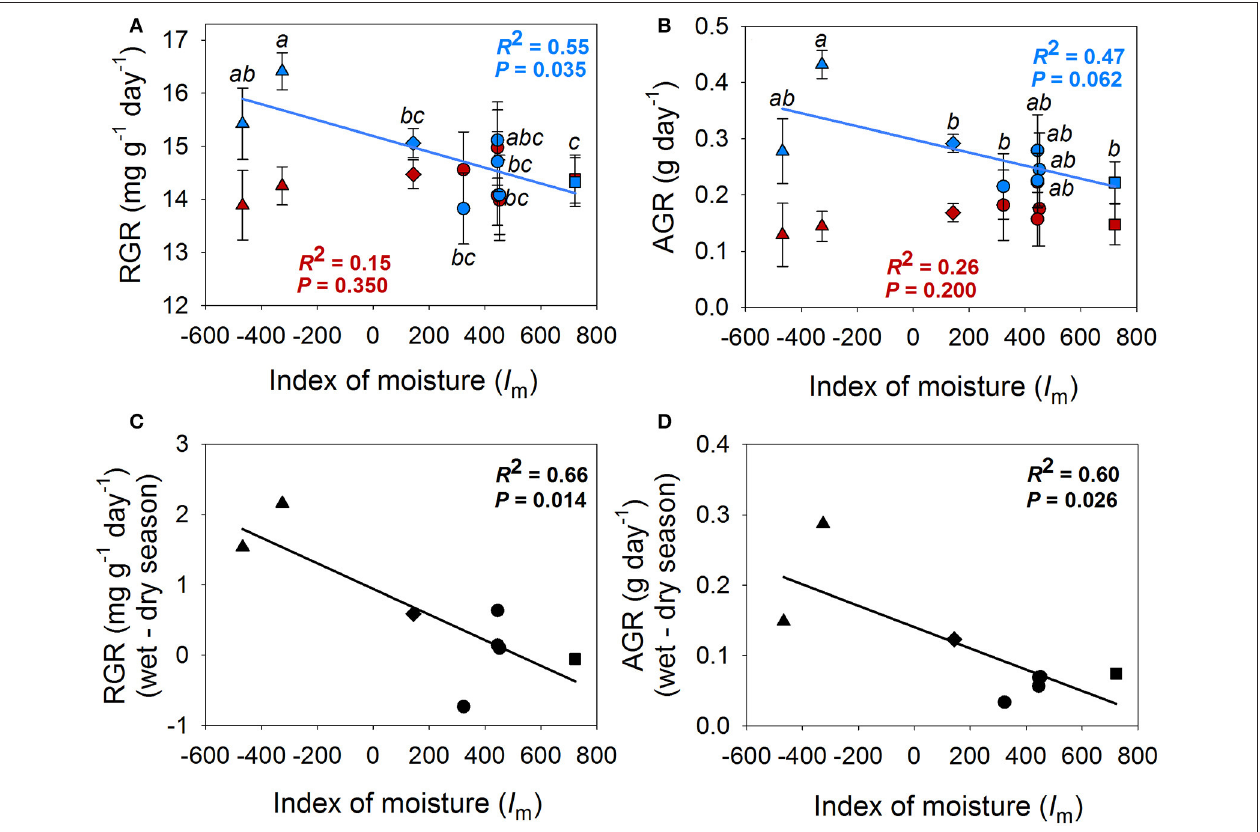
FIGURE 3 | Population means for relative growth rate (RGR) (A) , absolute growt rate (AGR) (B) in the wet season (blue) and dry season (red) in realtion to the index of moisture of the population. (C) and (D) show the relationships between the difference in RGR and AGR between seasons and the index of moisture of the population ( I m ). Points indicate population means. Standard errors could only be calculated for intra-season means (A,B) . Populations that belong to the same climate region are represented by the same symbols; Honduras: triangles, Dry Costa Rica: diamonds, Belize: circles, Mesic Costa Rica: